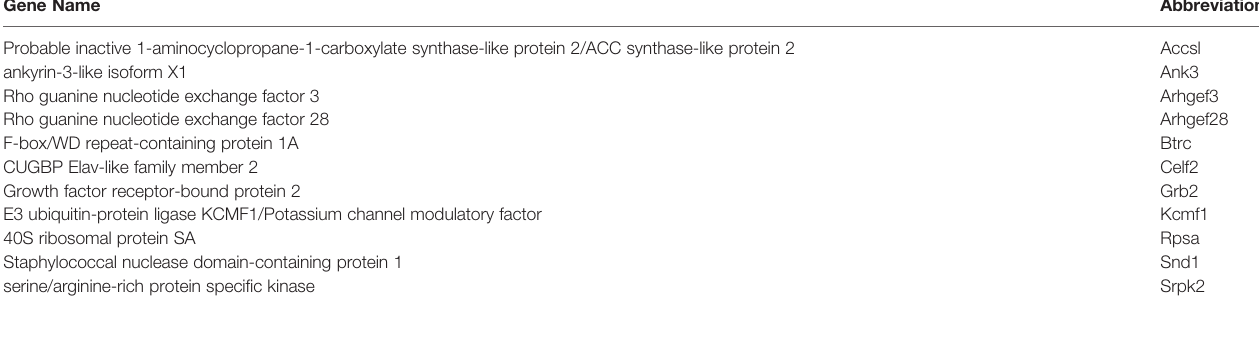
TABLE 3 | Differentially expressed genes related to fatty acid metabolism among different sexes and different PUFA abundance groups of Strongylocentrotus intermedius .